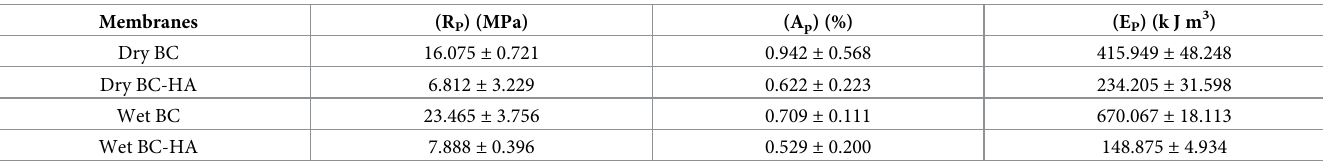
Table 2. Mechanical properties of membranes.